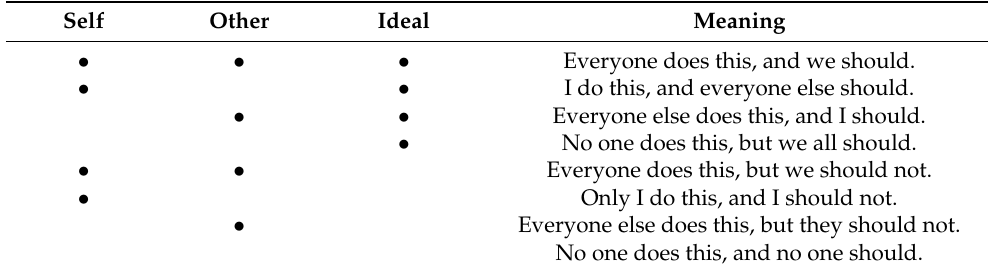
Table 1. Interpretations of indications of self, others and ideal combinations [19].